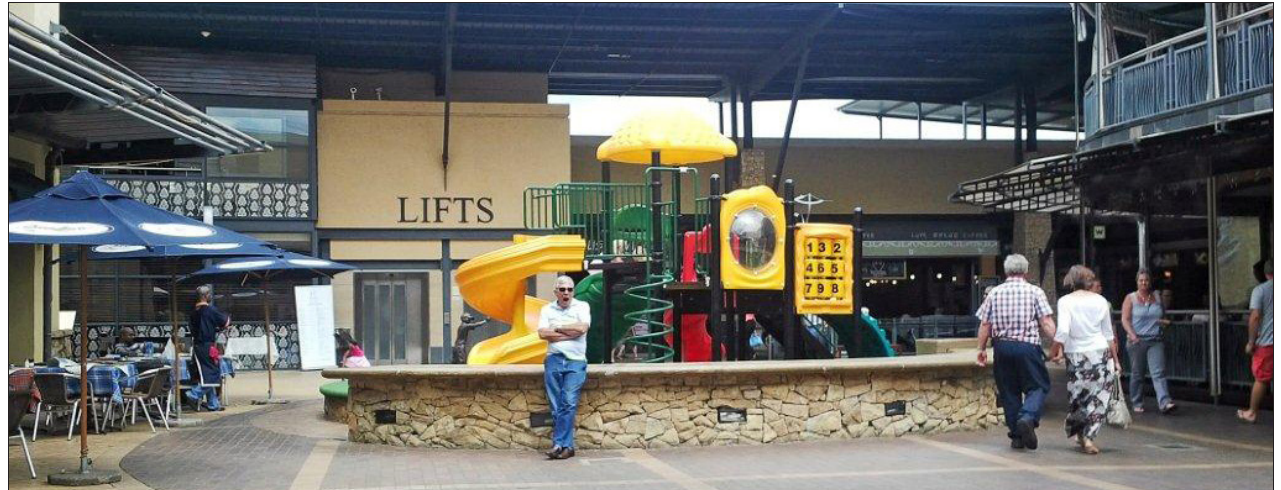
Figure 9: Woodlands Mall plaza: Looking towards the other side with restaurants and shops in the background and people sitting on the low wall Source: Author